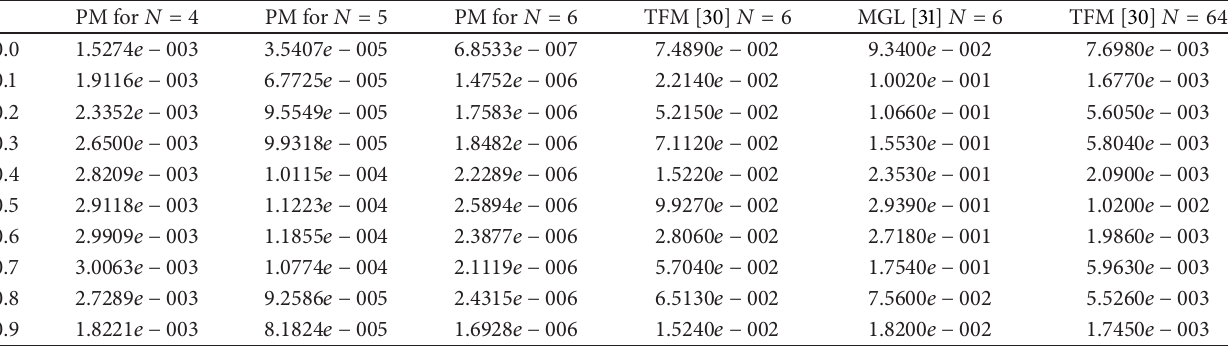
Table 2: The error histories at the selected points for Example 4.